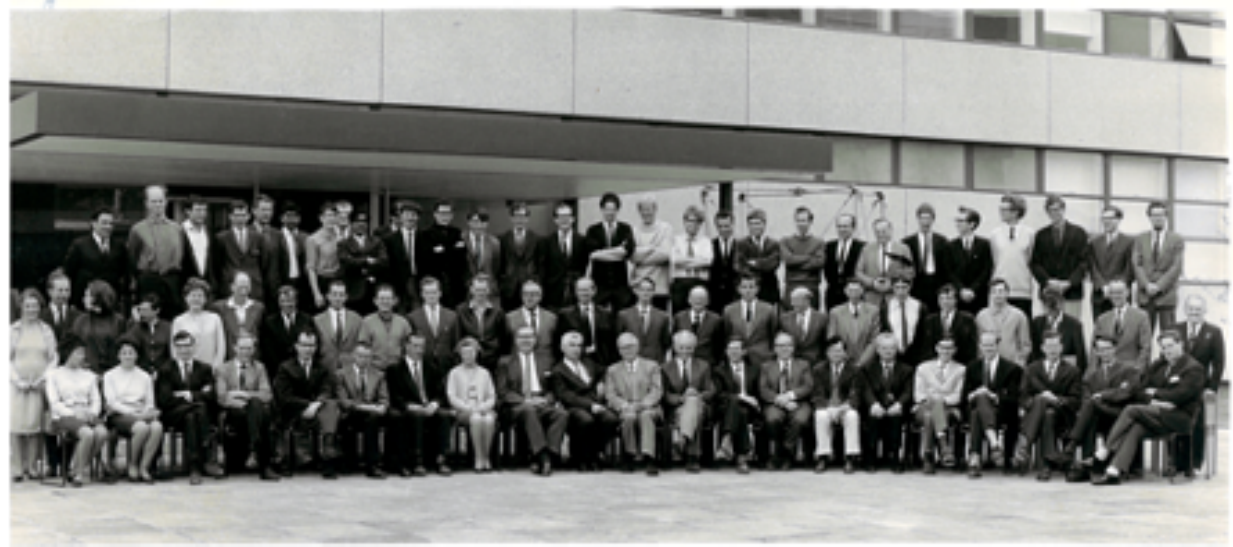
Figure 2. Southampton University Physics Department, circa 1967. Rycroft is seated in the front row, fourth from the right. Reproduced with permission of the current head of department, Prof. Mark Sullivan.